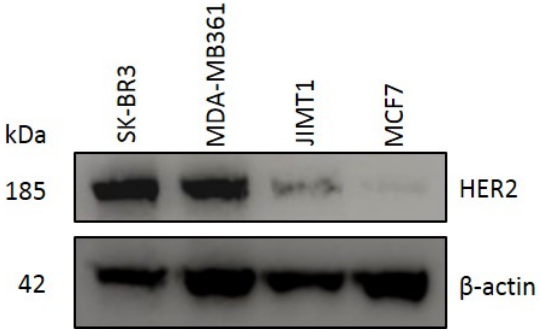
Figure 2. Western blotting analysis of HER2 protein in breast cancer cell lines (SK-BR3, MDA-MB361, JIMT1, and MCF7). β -actin protein expression was assessed as a control. A strong band with a molecular weight of 185 kDa, corresponding to HER2 protein, was observed in SK-BR3, MDA-MB361, and JIMT1 cells.